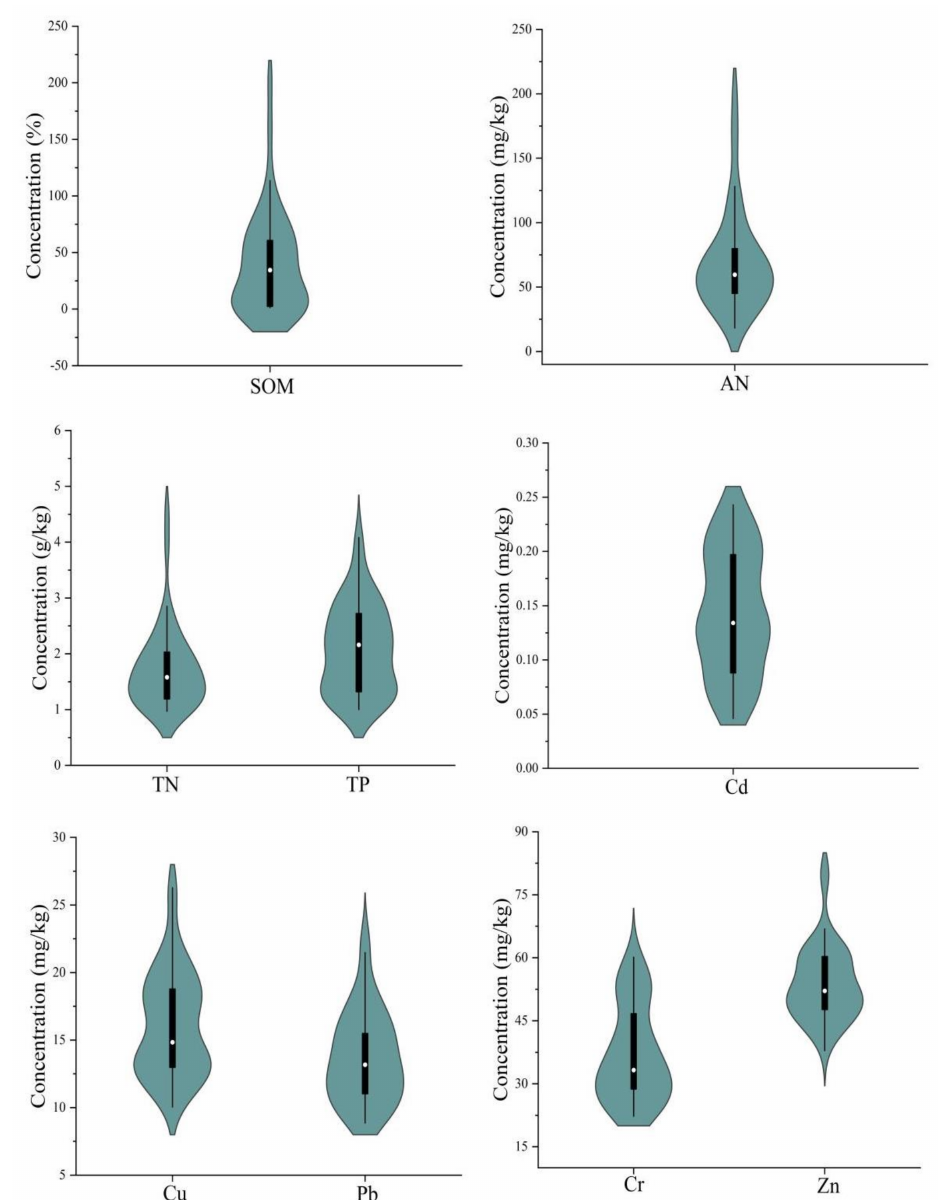
Figure 2. Violin of soil property concentrations (n = 43). The white point represents the median value of concentration. The black boxes range from the lower quartile to the upper quartile. The tentacles extend to the most extreme data point, which do not exceed 1.5 times the IQR (interquartile spacing) of the